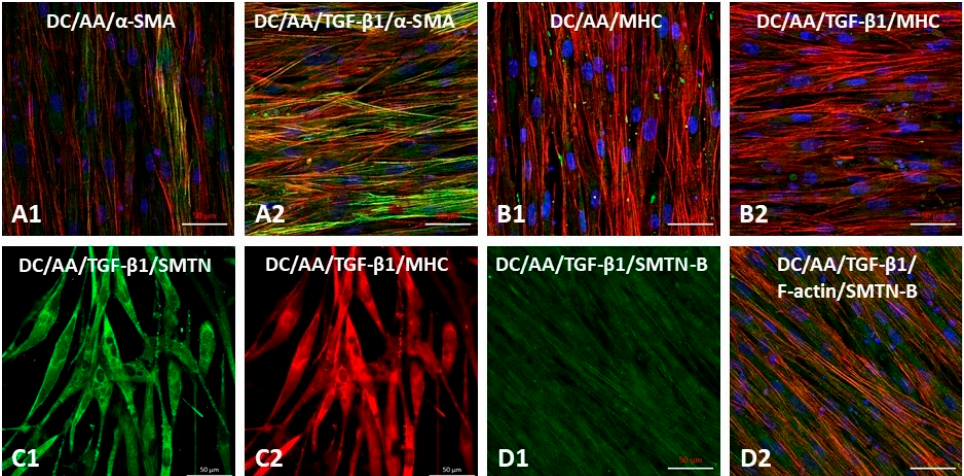
Figure 6. Characteristic analysis of smooth muscle markers by iMSCs seeded on P α APz-A fibrous mats addition with L-AA or L-AA/TGF- β 1 in DC culture media. After 7 days of pre-differentiation, α -SMA ( A1,A2 ) and MHC ( B1 , B2 ) were determined by immunofluorescence staining. ( C1 ,C 2 ) Representative confocal images of SMTN (green) and MHC (red) by iMSCs after 12 days of cultivation. ( D1 , D2 ) Co-localization of SMTN-B (green) and F-actin (red) by iMSCs after 12 days of cultivation. Scale bar = 50 µm.